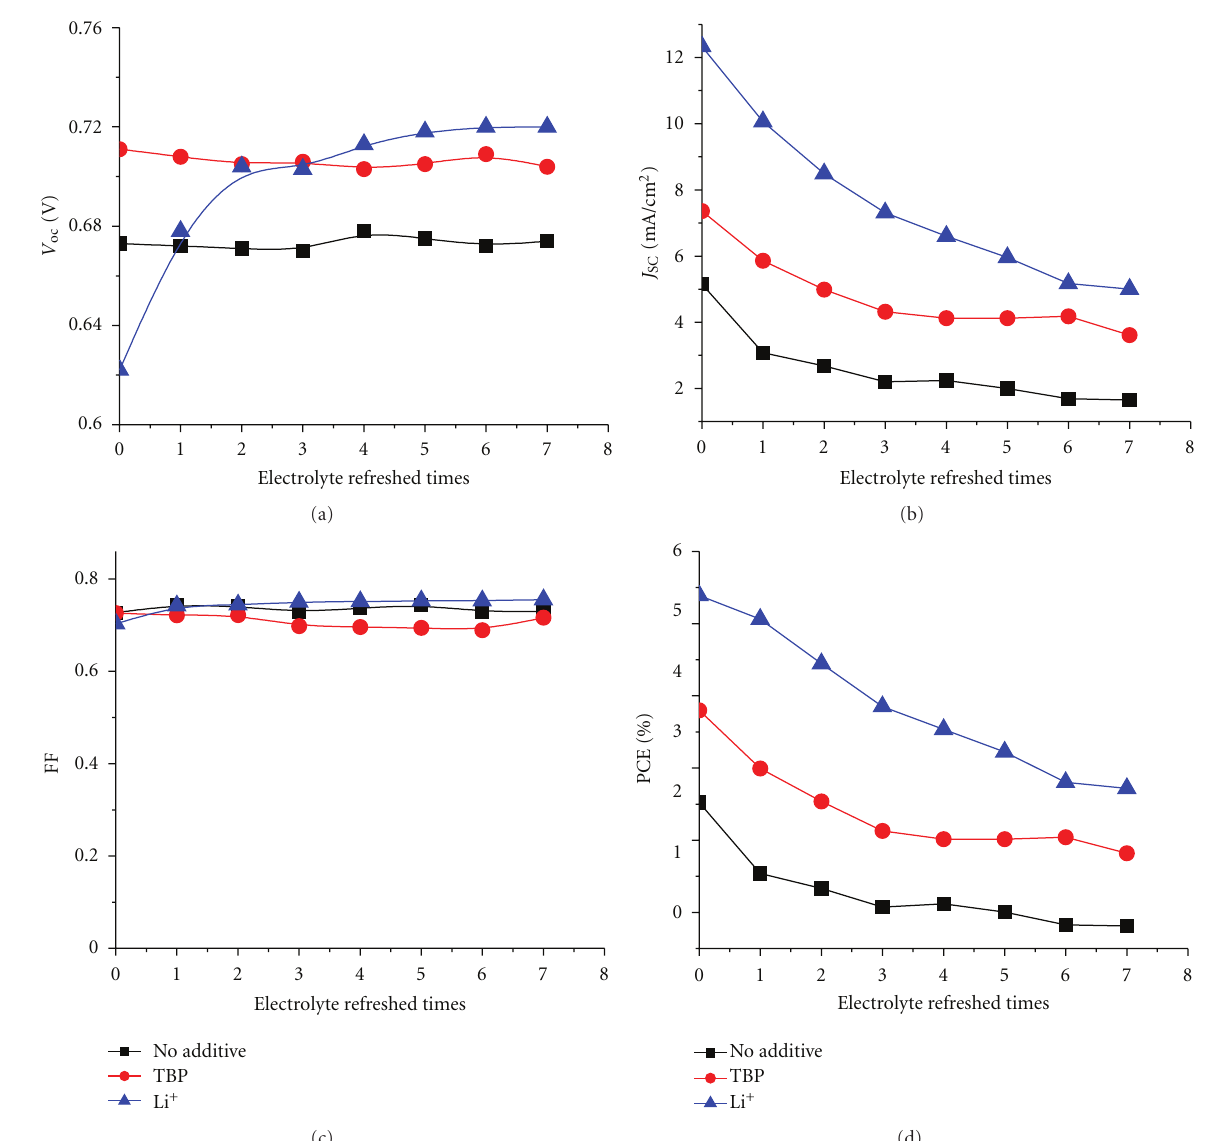
Figure 6: I - V parameters ( V oc (a), J sc (b), FF (c), and PCE (d)) of devices based on di ff erent electrolytes varied with electrolyte refreshing times. No additive: 0.04M I 2 and 0.6M BMII; TBP: 0.04 M I 2 , 0.6M BMII, and 0.03 M TBP; Li + : 0.04 M I 2 , 0.6 M BMII, and 0.05M